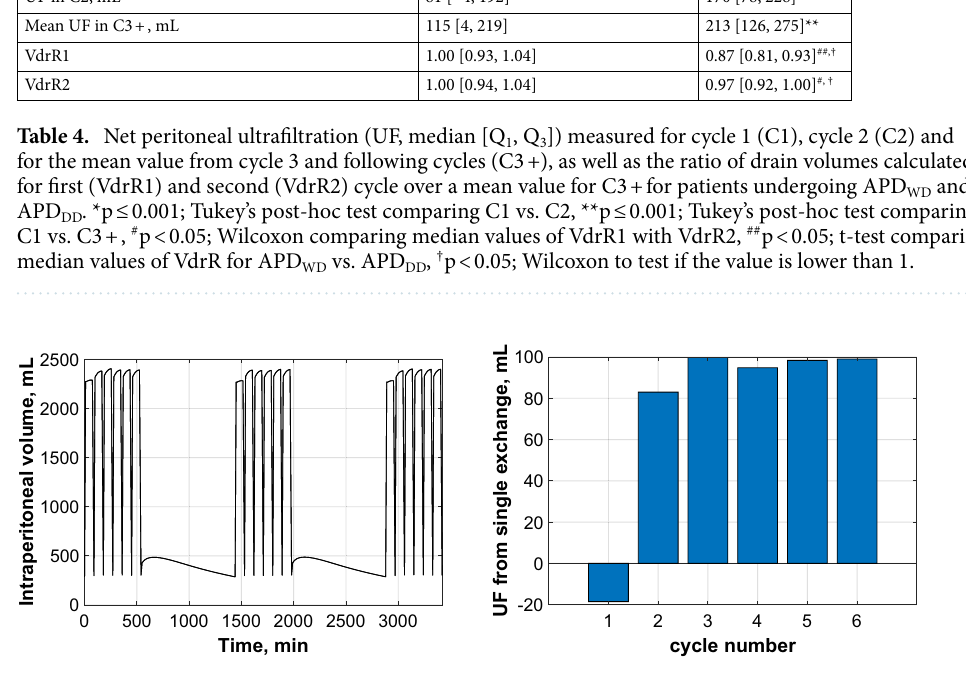
Figure 2. Numerical simulations for a typical APD DD patient showing negative net UF during the first APD cycle in contrast to positive net UF during the consecutive five cycles. Intraperitoneal volume profiles as a function of time during three consecutive APD sessions (consisting of six 90-min exchanges with 2 L of glucose 1.36%) interrupted by dry days (with infusion of 100 mL of glucose 1.36%) (left panel) and the corresponding net UF per each of the 6 single exchanges of the last (third) day’s APD session (right